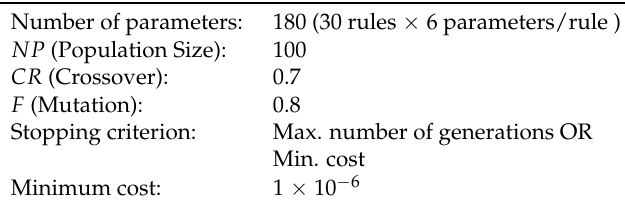
Figure 11. ( a ) 13th band of a highly spectrally mixed synthetic 64-band image, ( b ) Detail (marked with a yellow square in Figure 11a) of the associated ground truth, ( c ) 13th band of the detailed area, ( d ) 13th band of the CA output over the detailed area, ( e ) Spectra of pixels shown in Figure 11c, ( f ) Spectra of pixels shown in Figure 11d. Table 1. Differential Evolution (DE) parameters.